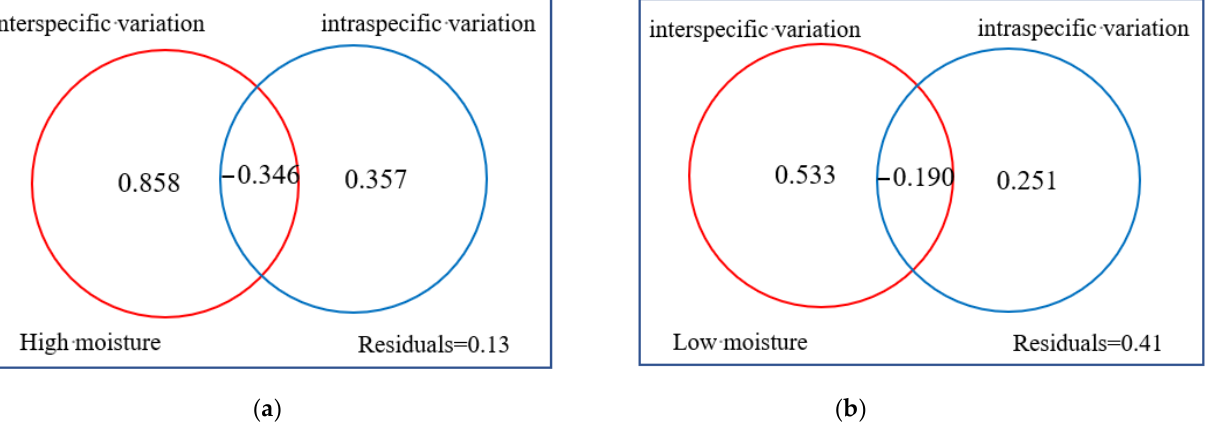
Figure 5. Contribution of intraspecific variation to community weighting under different soil mois- ture gradients. ( a ) High moisture gradient; ( b ) low moisture